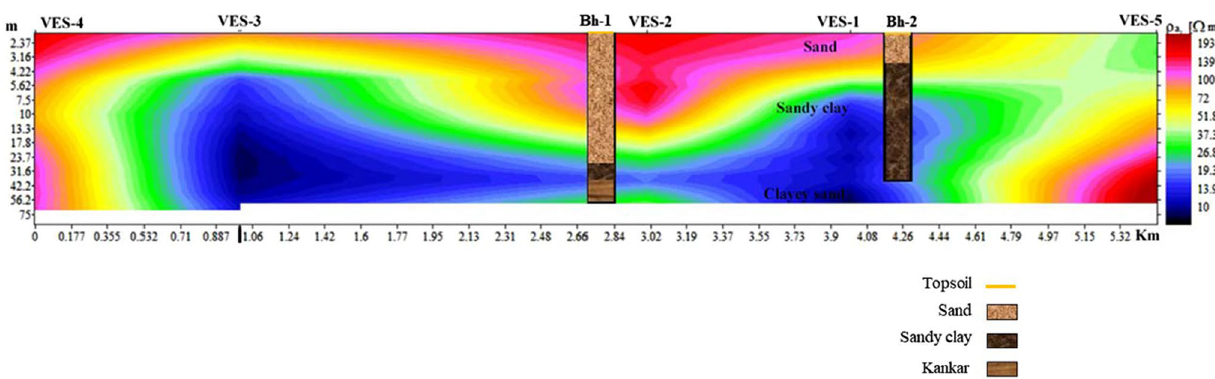
Fig. 16 Comparison of resistivity pseudo-cross section with borehole data of